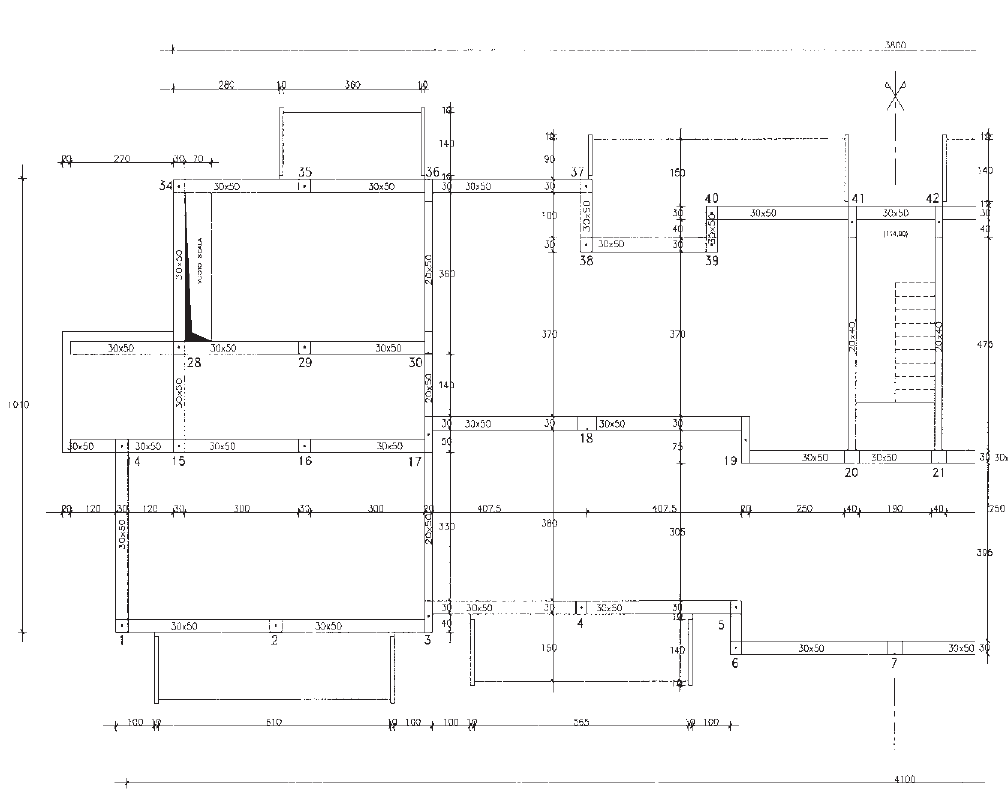
Fig. 10. Geometry of the Catania building: plane